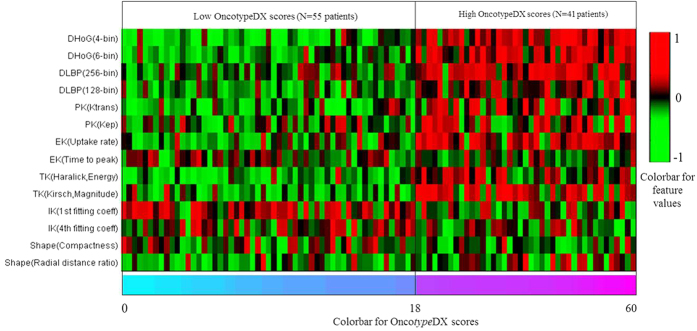
Heat map showing the values of best two identified features in each feature class (DHoG, DLBP, PK, EK, TK, IK, shape).The columns represent breast tumors and rows represent features. DHoG = dynamic histogram of oriented gradient; DLBP = dynamic local binary pattern; PK = pharmacokinetics; EK = enhancement kinetics; TK = textural kinetics; IK = intensity kinetics.